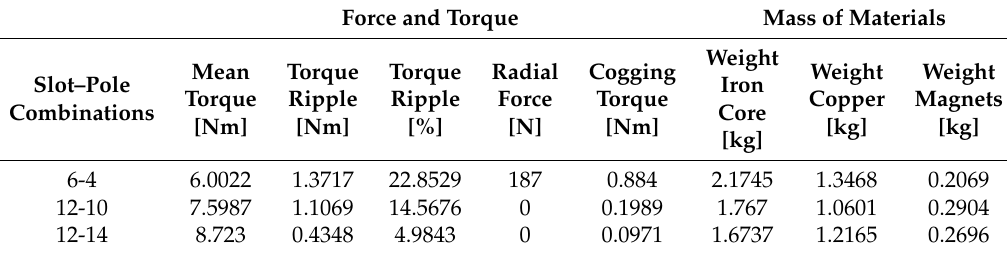
Table 8. Performance of healthy SL slot–pole combinations, Part I.